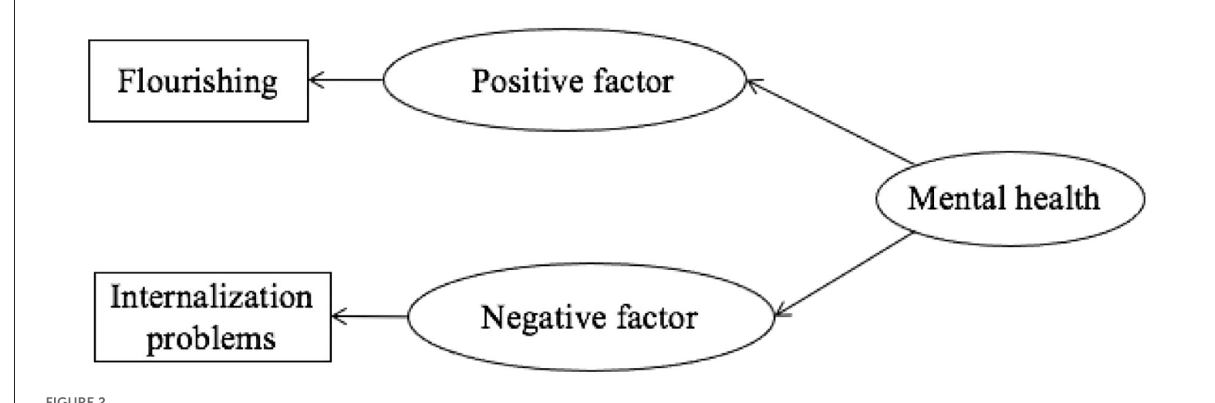
FIGURE2 Dual-factor model of mental